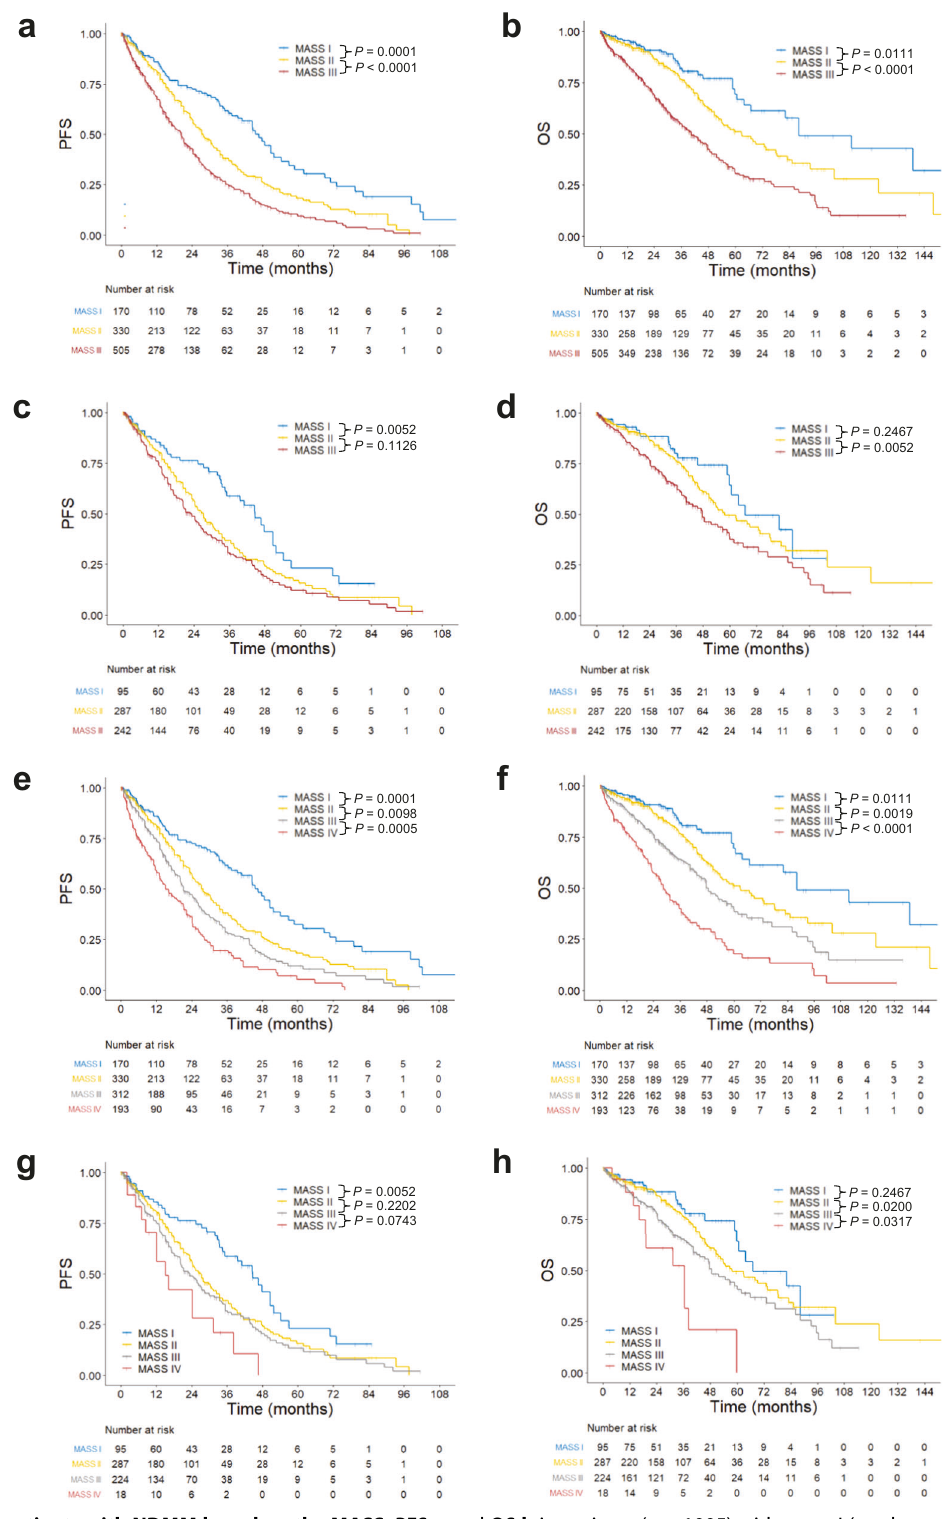
Fig. 1 Survival of patients with NDMM based on the MASS. PFS a and OS b in patients ( n = 1005) with stage I (total score = 0 point), II (total score = 1 point), and III (total score ≥ 2 points) determined by the 3-tier MASS, in which each high-risk factor (i.e., high-risk IGH translocation, 1q gain/ampli fi cation, chromosome 17 abnormality, ISS stage III, or elevated LDH) scored one point. PFS c and OS d in R-ISS II patients ( n = 624) with stage I, II, and III determined by the 3-tier MASS. PFS e and OS f in patients ( n = 1005) with stage I (total score = 0 point), II (total score = 1 point), III (total score = 2 points), and IV (total score ≥ 3 points) determined by the 4-tier MASS, in which each high-risk factor described above scored one point. PFS g and OS h in R-ISS II patients ( n = 624) with stage I, II, III, and IV determined by the 4-tier MASS.